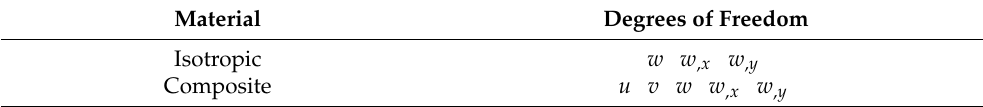
Table 1. Degrees of freedom considered for different kind of materials.